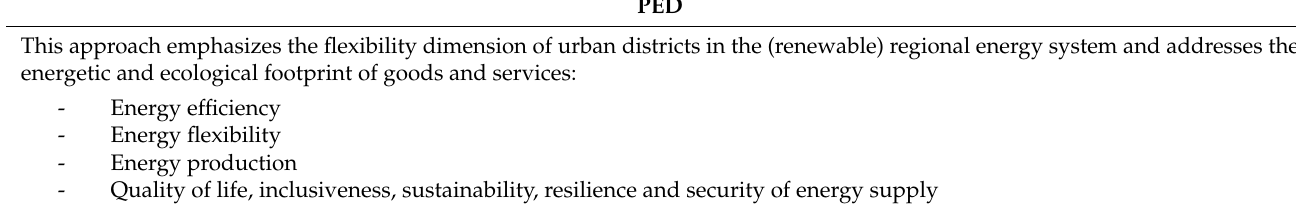
Table 3. The PED concept.